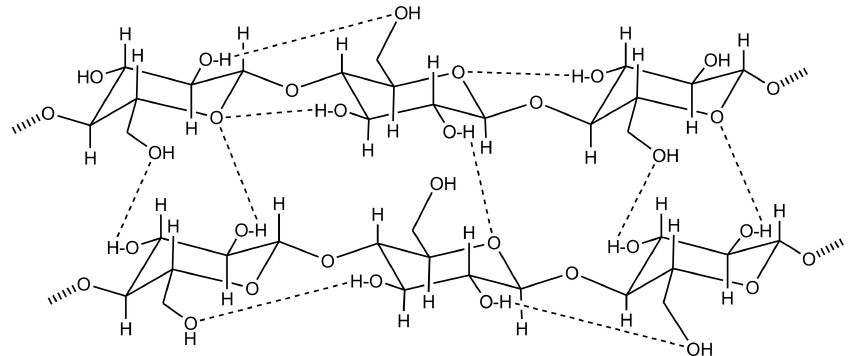
Figure 2. Cellulose structure demonstrating intra- and intermolecular hydrogen bonding